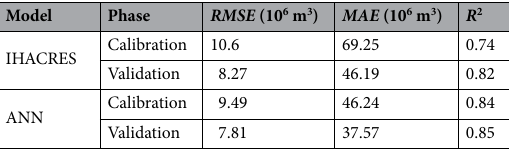
Table 4. Statistical metrics for the IHACRES and ANN